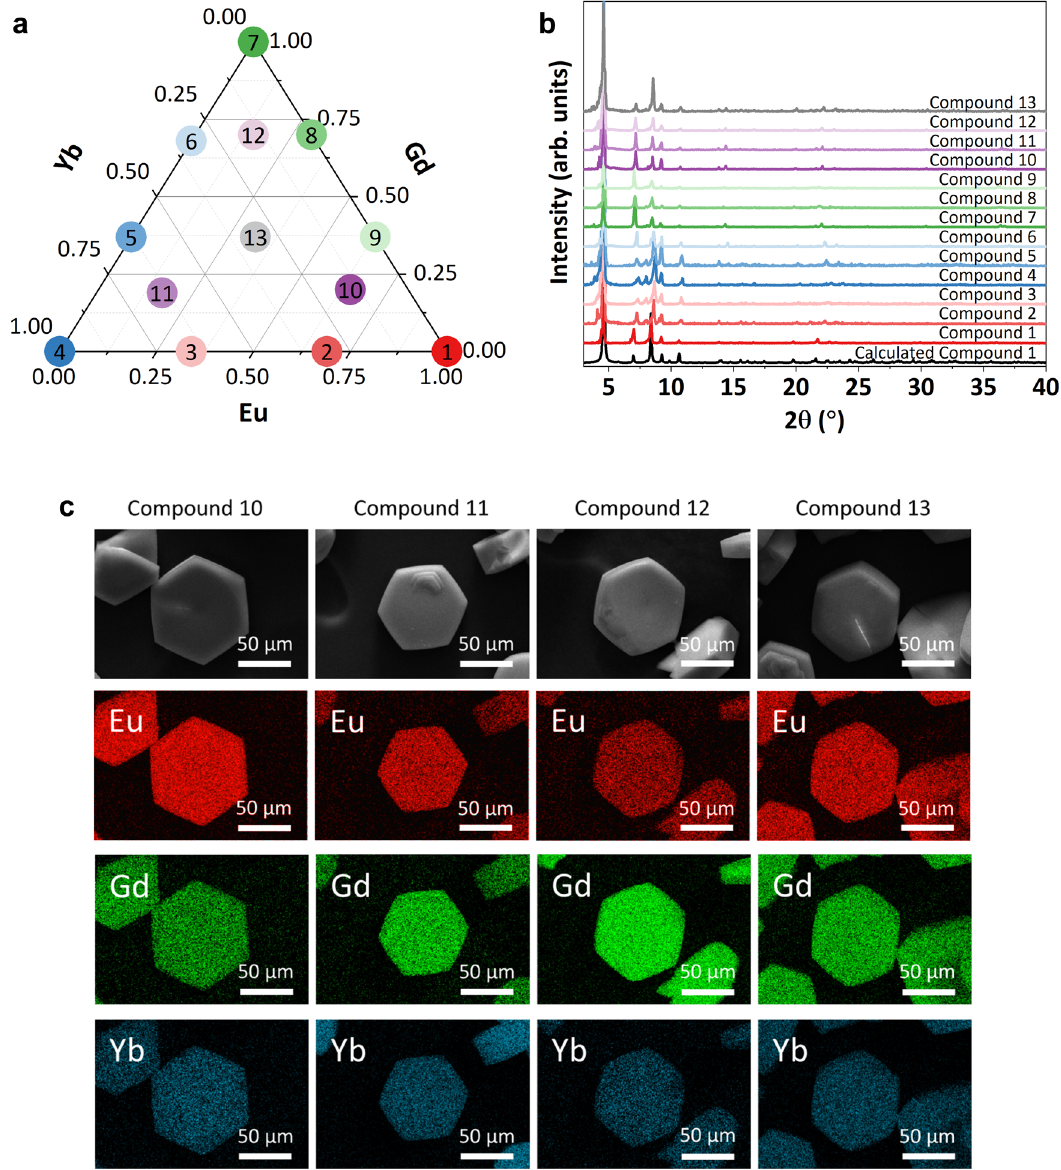
Fig.2|Informationregardingthecompositionandcrystallinityofthereported compounds.a Ternarydiagramofmetalcontentshowingthecompositionofeach compound in the study. b Powder X-ray diffraction patterns for each compound reported in this work, highlighting their consistent crystallinity and the slight